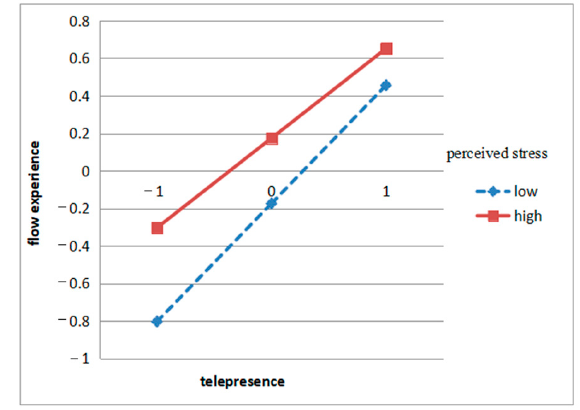
Figure 5. Interaction effects of perceived stress and telepresence on flow experience.